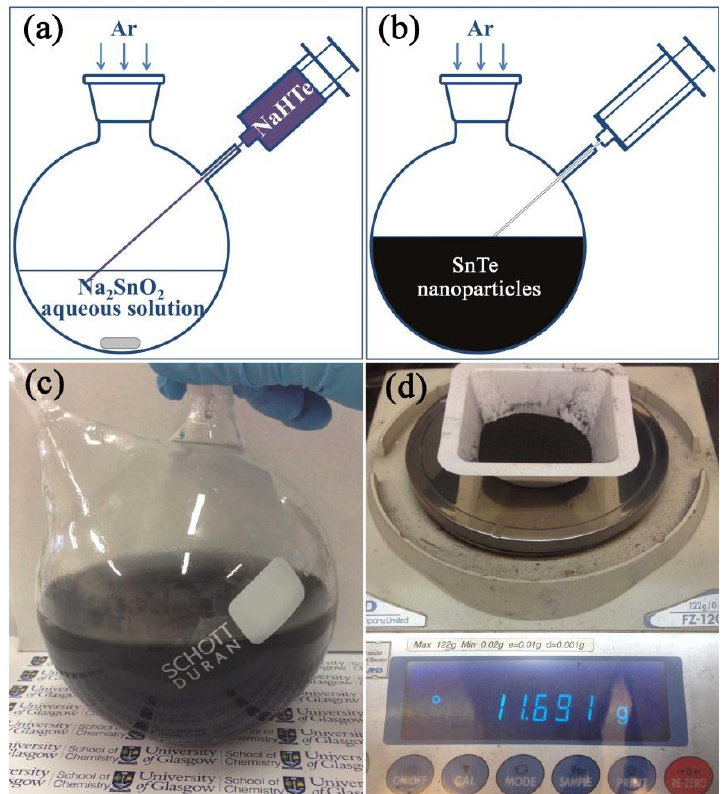
synthesis of SnTe nanoparticles: schematic drawings